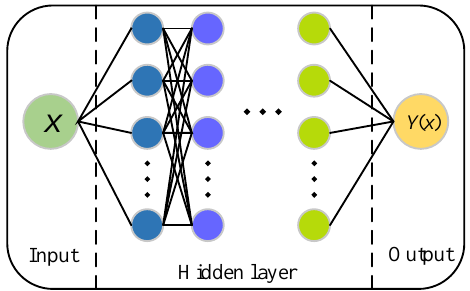
Figure 12. Fundamental structure of multilayer perceptron.